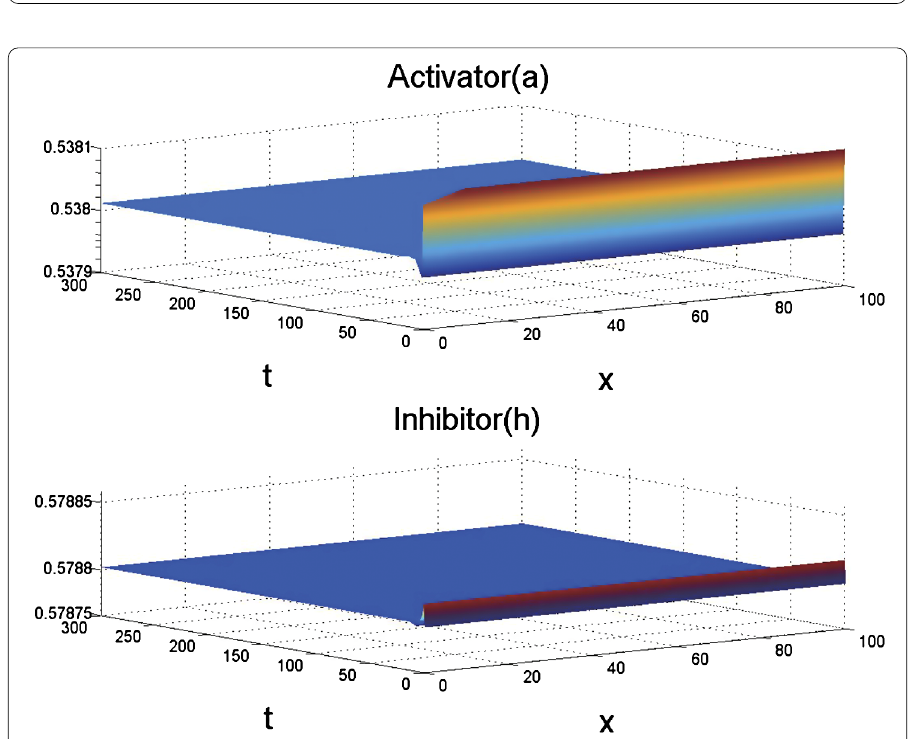
Figure 7 The persistence of the stable equilibrium under conditions (H2) and